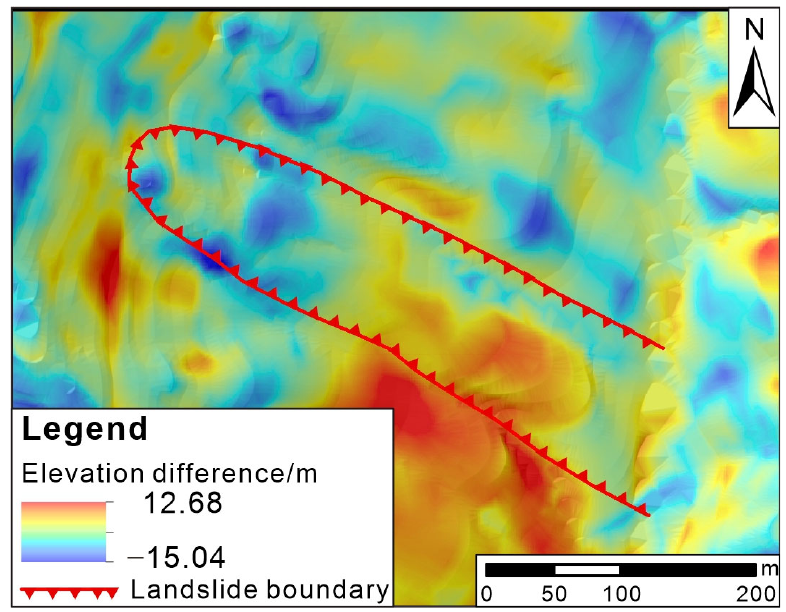
Figure 6. The elevation differences between the topographic mappings in November 2012 and March 2017.